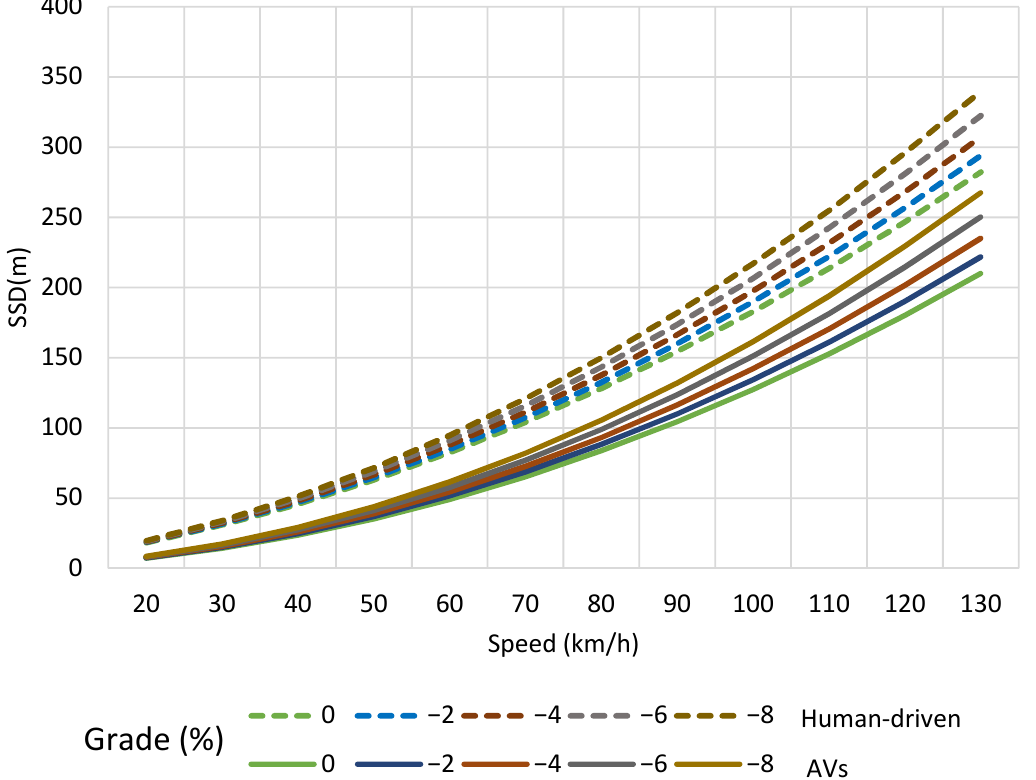
Figure 3. SSD for different downgrades for both human-driven vehicles and AVs.